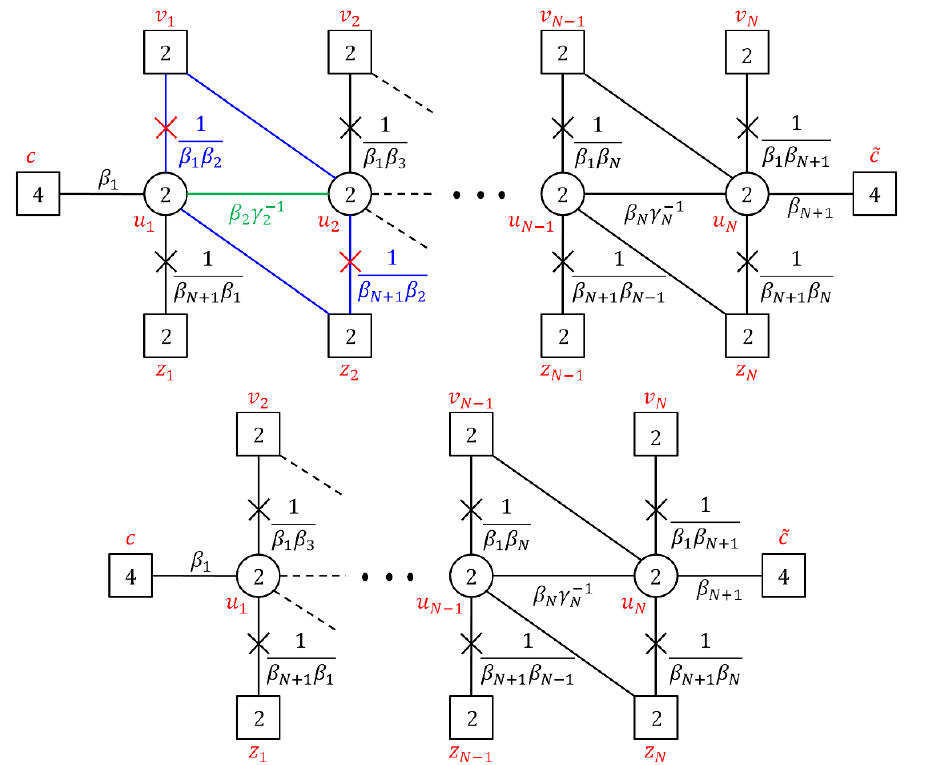
Figure 17 . Quiver diagrams of the (cid:13)ux tube in class S D by the vev, and the (cid:13)ux tube in class S D